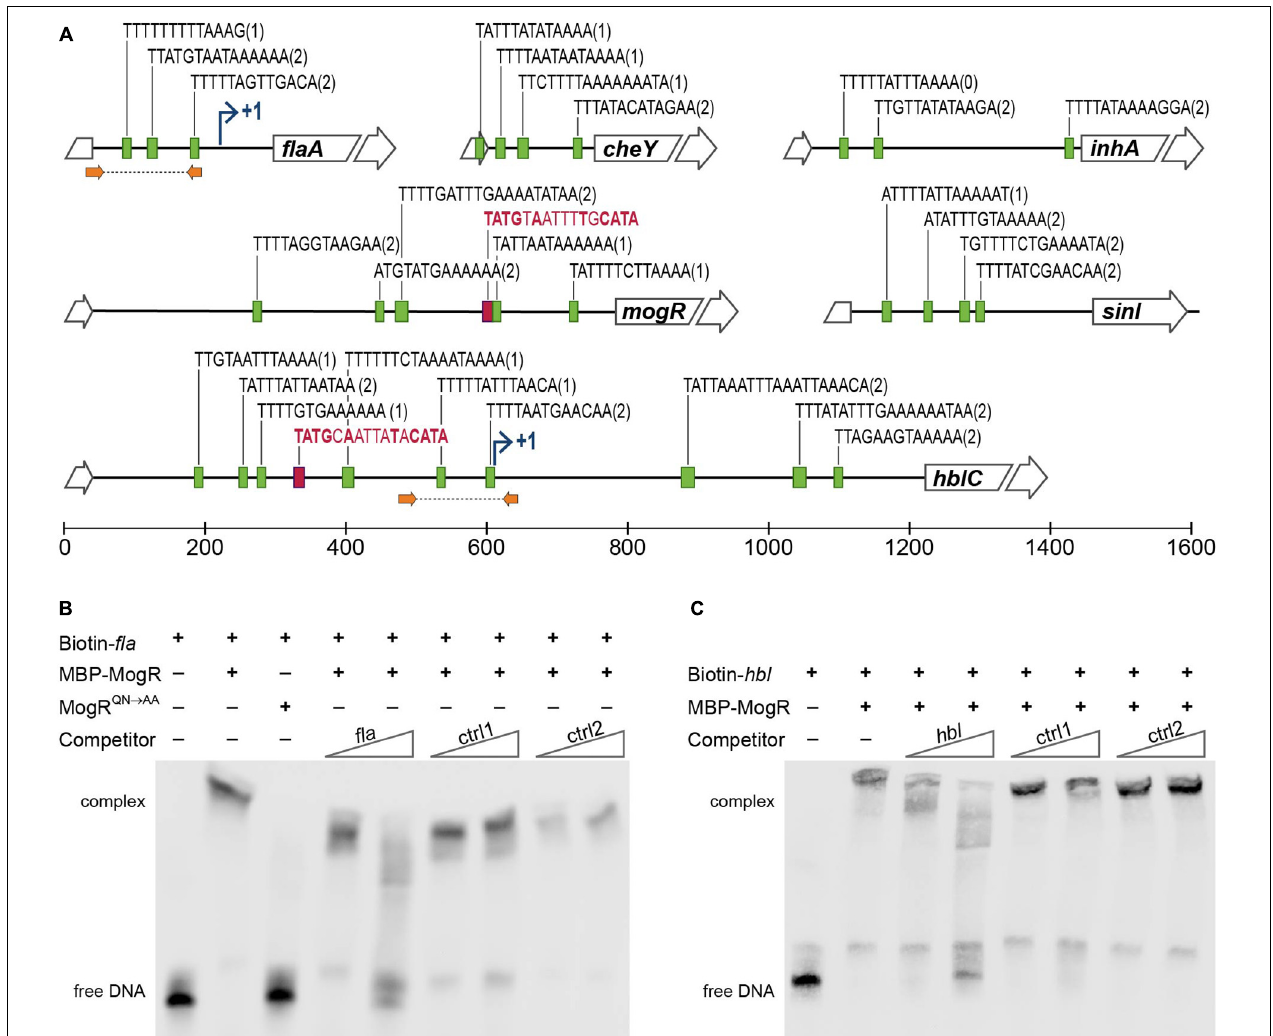
FIGURE 5 | MogR binding to promoter regions in B. thuringiensis 407. (A) Putative MogR binding sites (indicated by green boxes) in the intergenic regions upstream of the flaA, cheY, inhA, mogR, sinI and hblC genes, allowing up to two mismatches from the sequence TTTTWWNWWAAAA, with the number of mismatches in parentheses. Putative PlcR boxes, TATGNANNNNTNCATA, are included in red (only perfect matches included). Broken arrows indicates transcriptional start sites where applicable. Location of primers used for generating fla and hbl promoter sequence probes for the electrophoretic mobility shift assay (EMSA) in (B,C) are indicated with orange arrows. (B,C) EMSAs of purified MBP-MogR fusion protein binding to purified PCR products representing the promoter regions of flaA (B) and hblC (C) , as indicated in (A). Biotin-labeled fla or hbl DNA fragments were incubated with 1 µ g (equivalent to 1.4 µ M) purified MBP-MogR protein, in the presence or absence of unlabeled competitor DNA at 50-fold or 1000-fold molar excess: fla or hbl fragment, and non-specific competitors ctrl1 ( B. thuringiensis 407 BTB_RS08990) and ctrl2 (gene encoding Epstein Barr virus nuclear antigen). In (B) , 1 µ g MBP-MogR QN → AA was used for DNA binding, as a